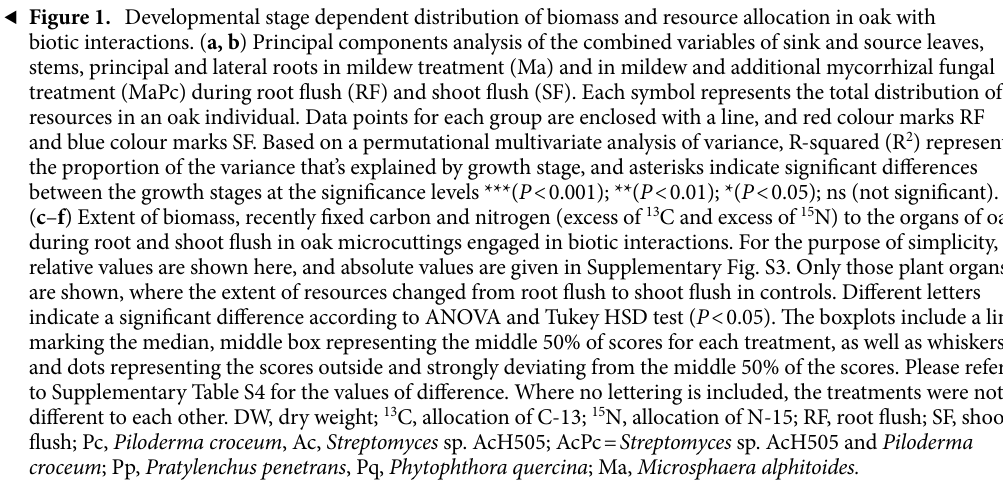
Figure 1. Developmental stage dependent distribution of biomass and resource allocation in oak with biotic interactions. ( a, b ) Principal components analysis of the combined variables of sink and source leaves, stems, principal and lateral roots in mildew treatment (Ma) and in mildew and additional mycorrhizal fungal treatment (MaPc) during root flush (RF) and shoot flush (SF). Each symbol represents the total distribution of resources in an oak individual. Data points for each group are enclosed with a line, and red colour marks RF and blue colour marks SF. Based on a permutational multivariate analysis of variance, R-squared (R 2 ) represents the proportion of the variance that’s explained by growth stage, and asterisks indicate significant differences between the growth stages at the significance levels ***( P < 0.001); **( P < 0.01); *( P < 0.05); ns (not significant). ( c – f ) Extent of biomass, recently fixed carbon and nitrogen (excess of 13 C and excess of 15 N) to the organs of oak during root and shoot flush in oak microcuttings engaged in biotic interactions. For the purpose of simplicity, relative values are shown here, and absolute values are given in Supplementary Fig. S3. Only those plant organs are shown, where the extent of resources changed from root flush to shoot flush in controls. Different letters indicate a significant difference according to ANOVA and Tukey HSD test ( P < 0.05). The boxplots include a line marking the median, middle box representing the middle 50% of scores for each treatment, as well as whiskers and dots representing the scores outside and strongly deviating from the middle 50% of the scores. Please refer to Supplementary Table S4 for the values of difference. Where no lettering is included, the treatments were not different to each other. DW, dry weight; 13 C, allocation of C-13; 15 N, allocation of N-15; RF, root flush; SF, shoot flush; Pc, Piloderma croceum , Ac, Streptomyces sp. AcH505; AcPc = Streptomyces sp. AcH505 and Piloderma croceum ; Pp, Pratylenchus penetrans , Pq, Phytophthora quercina ; Ma, Microsphaera